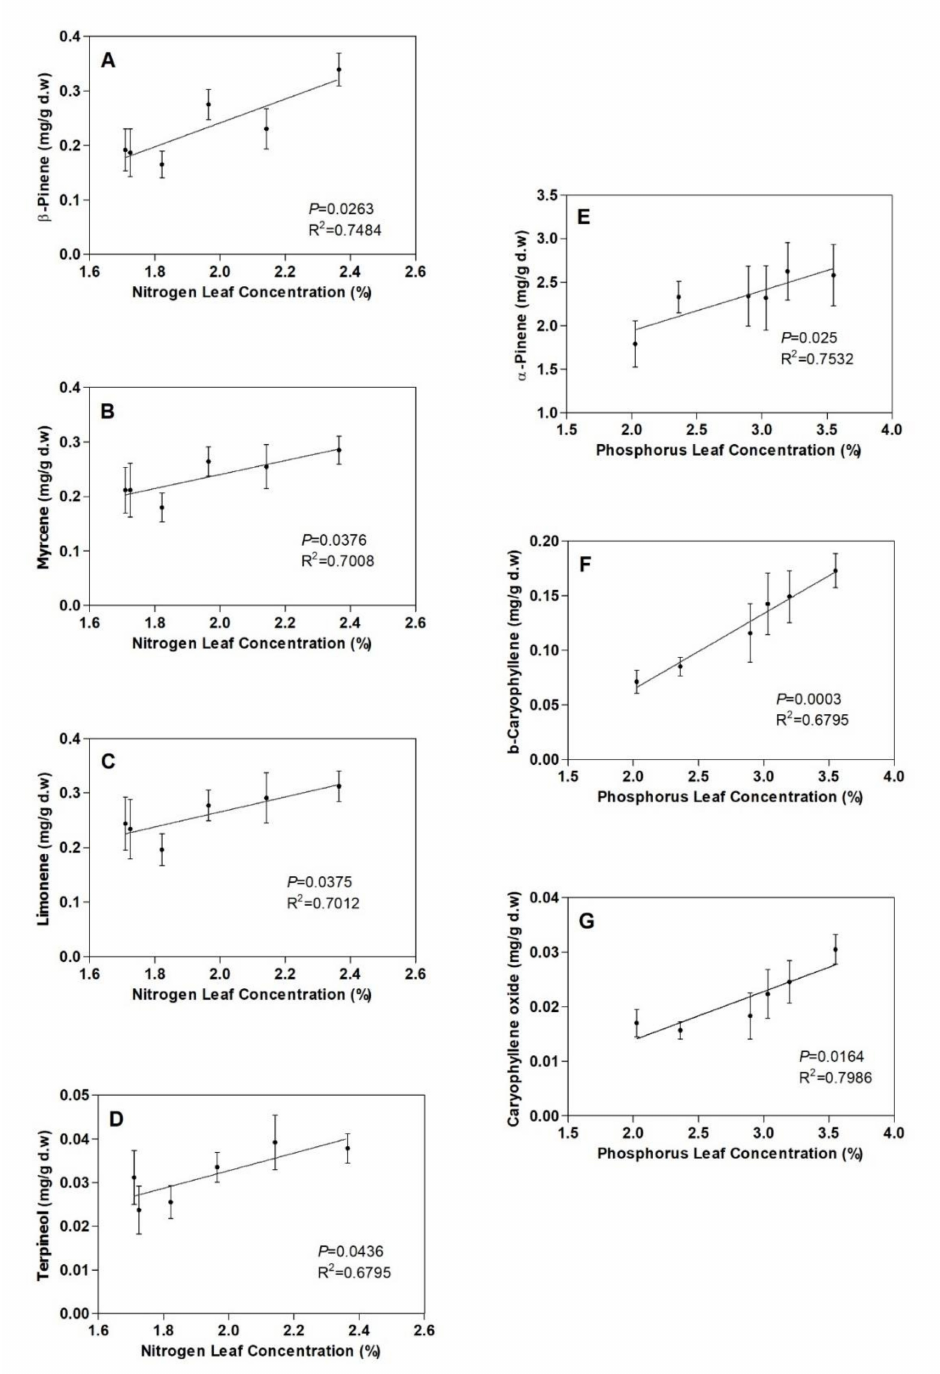
Figure 3. Correlation of leaf ( A ) β -pinene, ( B ) myrcene, ( C ) limonene and ( D ) terpineol concentrations with nitrogen leaf concentrations; correlation of leaf ( E ) β -pinene, ( F ) β -caryophyllene and ( G ) caryophyllene oxide concentrations with phosphorus leaf concentrations. Vertical bars indicate standard errors of the mean ( n =